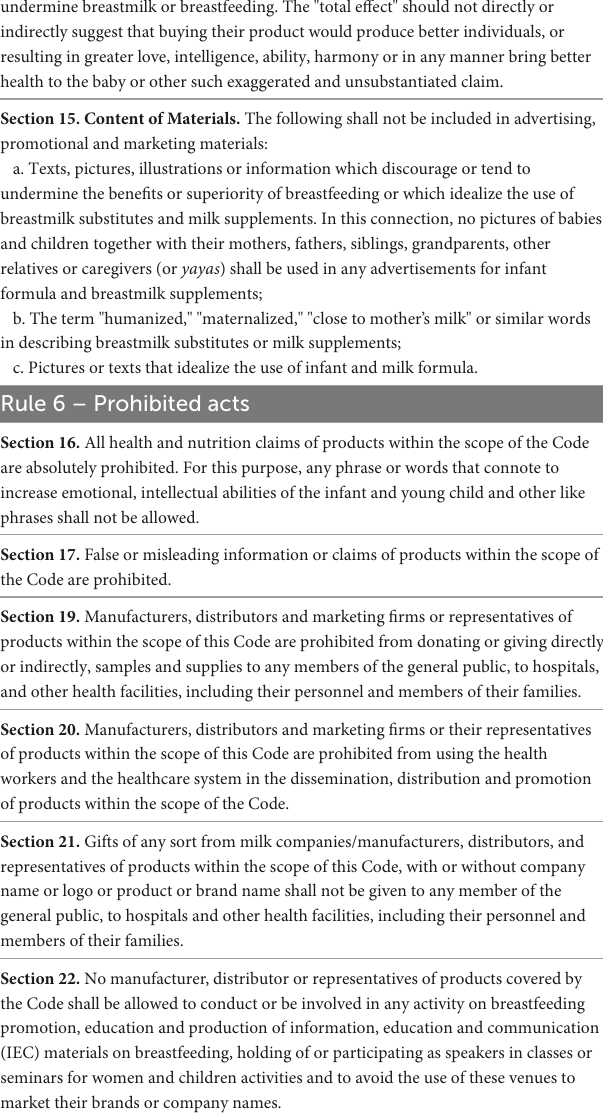
TABLE 1 Key provisions of the 2006 revised implementing rules and regulations of the Philippine Milk Code. Rule 5 – Advertising, promotion, marketing, and